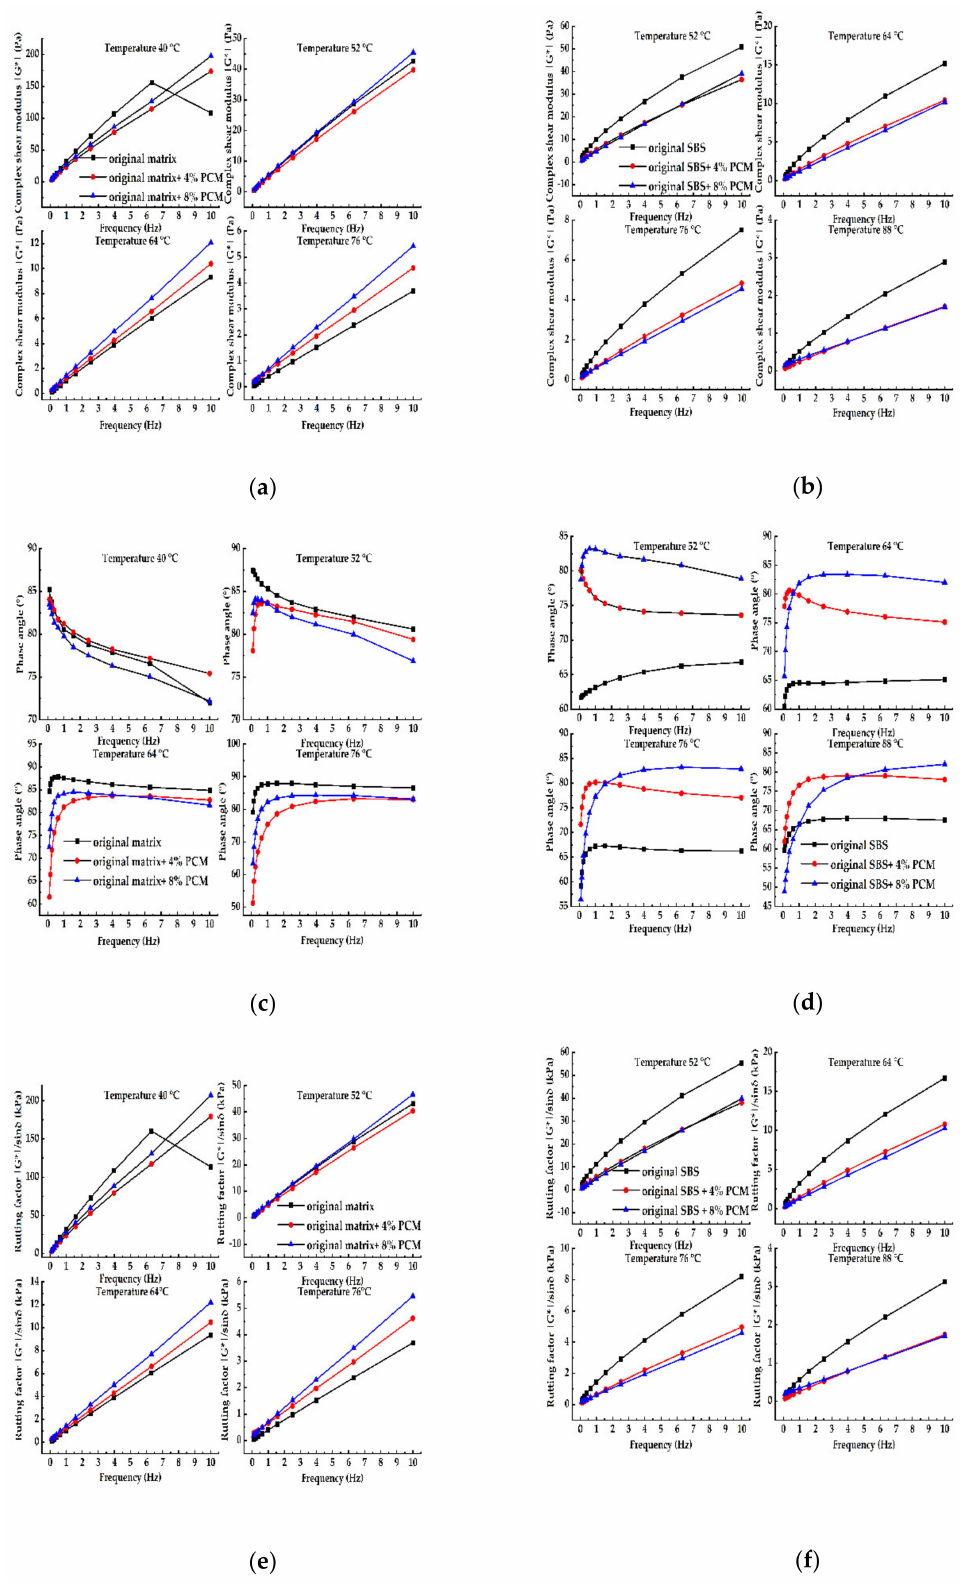
Figure 5. DSR frequency sweep test results of original asphalt samples with PCM under different test temperatures. ( a ) complex modulus of matrix asphalt samples; ( b ) complex modulus of SBS − modified asphalt samples; ( c ) phase angle of matrix asphalt samples; ( d ) phase angle of SBS − modified asphalt samples; ( e ) rutting factor of matrix asphalt samples; ( f ) rutting factor of SBS − modified asphalt